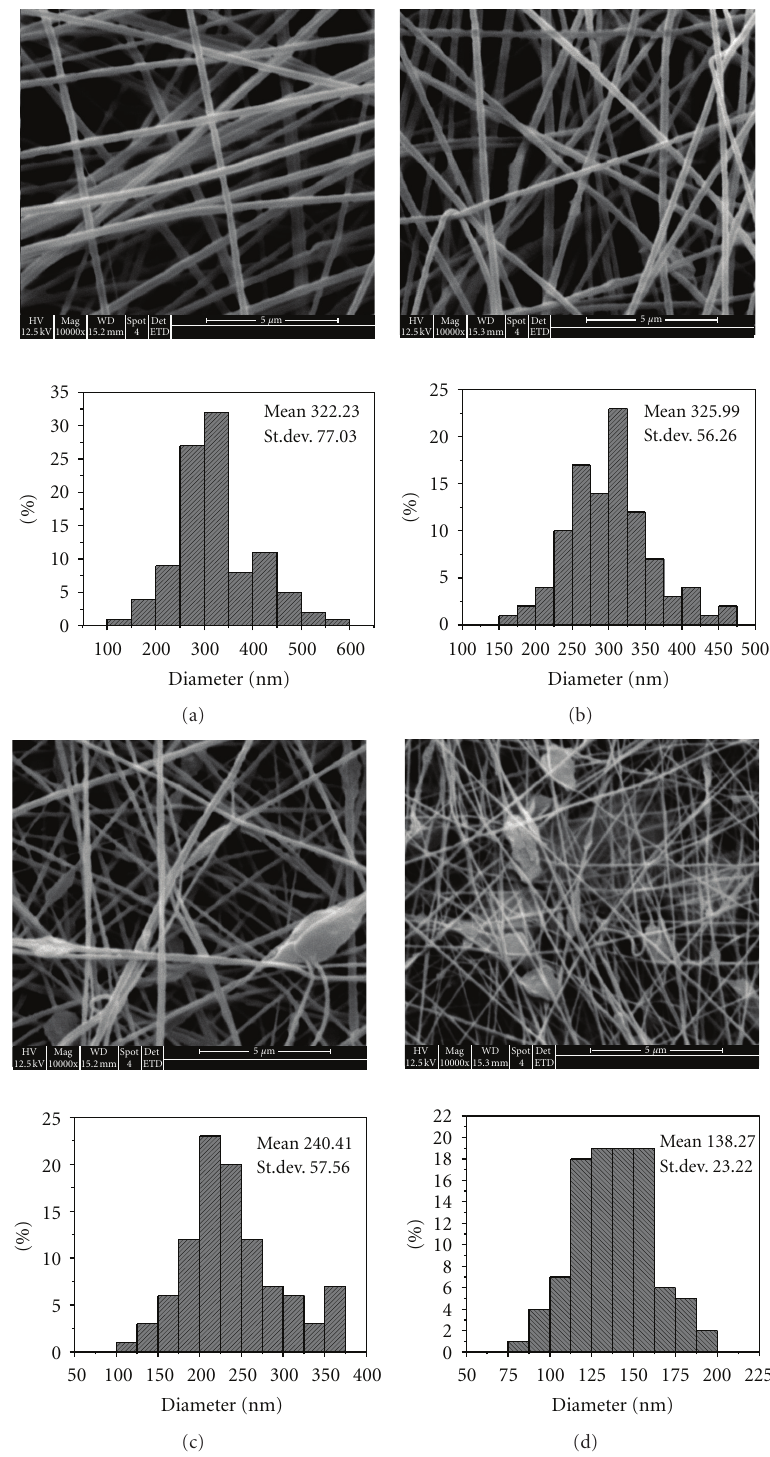
Figure 2: SEM images and diameter histogram distribution chart of PAN and PAN/O-MMT composite nanofibers: (a) 0wt.% O-MMT; (b) 1wt.% O-MMT; (c) 3 wt.% O-MMT; (d) 5wt.% O-MMT. were measured by Adobe Acrobat 7.0 professional from the distance measurement was clicked to measure the diameter SEM images, and 100 fibers were analyzed for each sample of the nanofibers. The zoom factor was set according to the to obtain an average fiber diameter. In detail, after the SEM scale plate in the SEM images before measuring. Every time images were opened by Adobe Acrobat professional, the the diameters were measured, a serial number was given